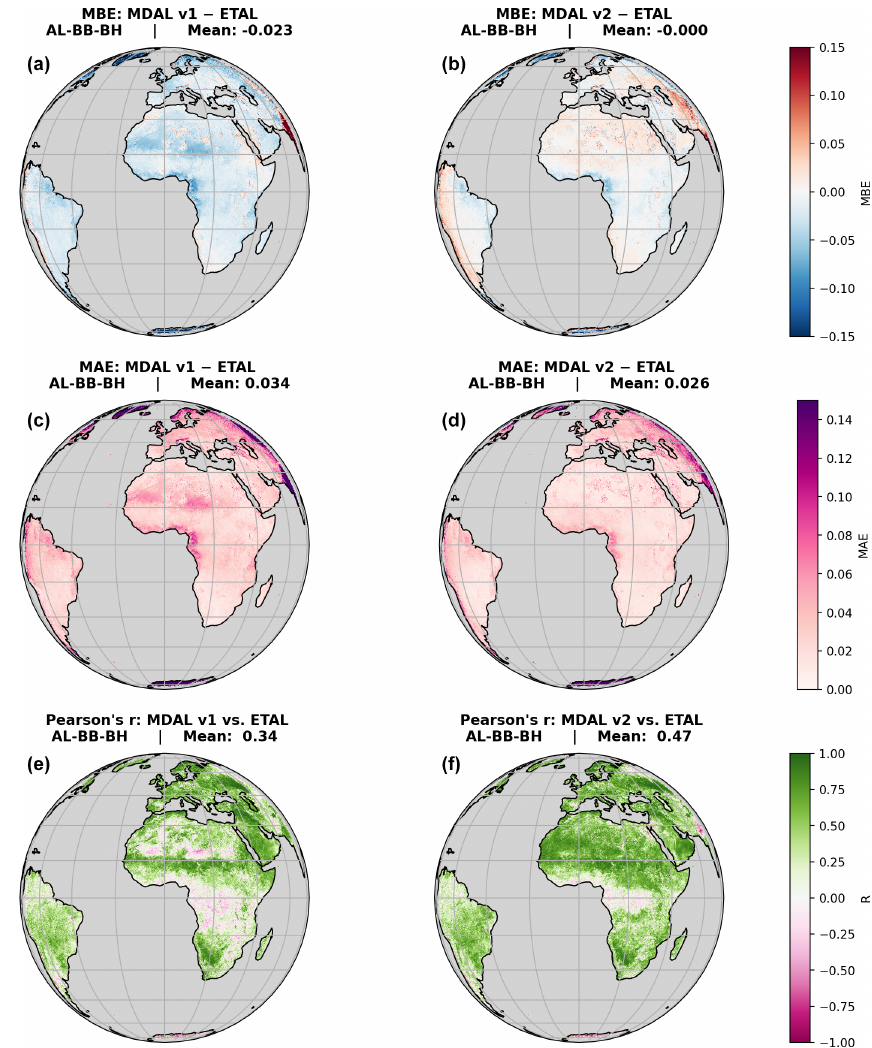
Figure 6. Plots showing performance of MDAL v1 and v2 against ETAL for all pixels, for AL-BB-BH and analysis over 1 full year, from 1 November 2020 to 31 October 2021. (a, b) MBE; (c, d) MAE; (e, f) Pearson’s correlation coefficient r